Question: Summarize what this figure shows in one sentence.
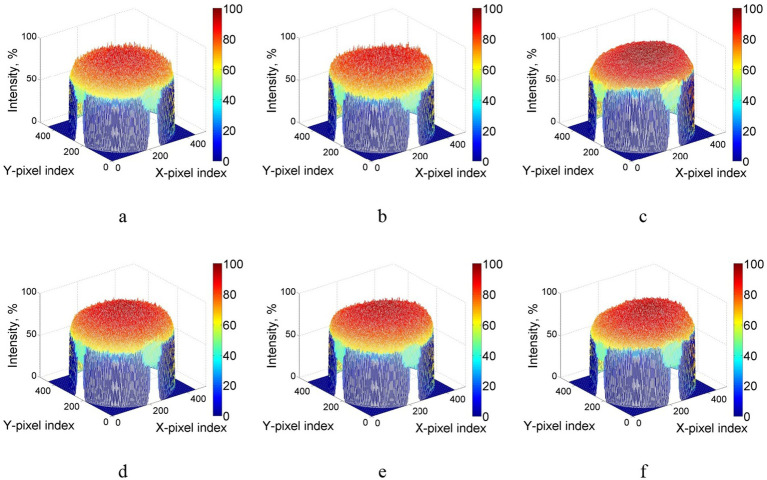
Answer: Uniformity of white paper illumination at different illumination-detection combinations: (a) – R-image at 659 nm illumination; (b) – G-image at 532 nm illumination; (c) – B-image at 448 nm illumination; (d,e,f) – R-, G- and B-images at simultaneous 3-wavelength illumination. Color scale represents relative intensities ( 11 ).